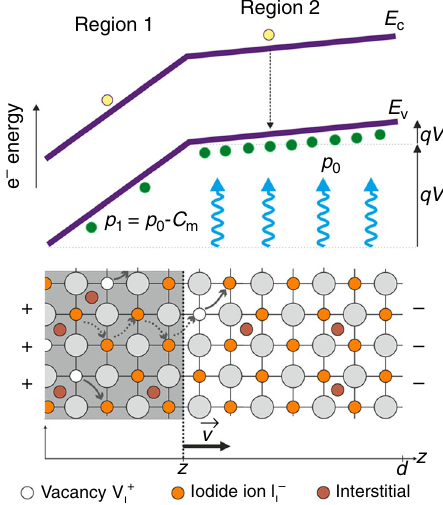
Fig. 2 Scheme of a physical model. Optoelectronic effects of iodine vacancies drifting in a perovskite layer with symmetric contacts, under the applied fi eld caused by positive bias at the left side. In this model of a p - doped material, the dominant electrical current fl owing across the symmetrical electrodes, is an electronic current. The unshaded region 2 shows the original situation of majority carrier holes of density p 0 (due to the intrinsic doping by iodine interstitials I (cid:2) ) that cause PL under i photogeneration of electrons by light soaking. The applied voltage induces an ion movement: iodine vacancies V þ drift in the electrical fi eld toward the I right. In the shaded region 1, they fi ll the space up to a density C m compensating the p -doping and reducing majority carrier density to p 1 = p 0 – C V , the conduction band E E m . With applied voltage c and valence band v bend by an amount qV = qV 1 + qV 2 , where q is elementary charge. The ionic current is negligible compared with electronic current (due to the enormous difference of ionic and electronic carrier mobilities) but ion displacement modi fi es the local extent of doping and in fl uences the majority carrier density and thus the total current changes (decreases) with time. Due to the drift of ions from the contact, the shaded region